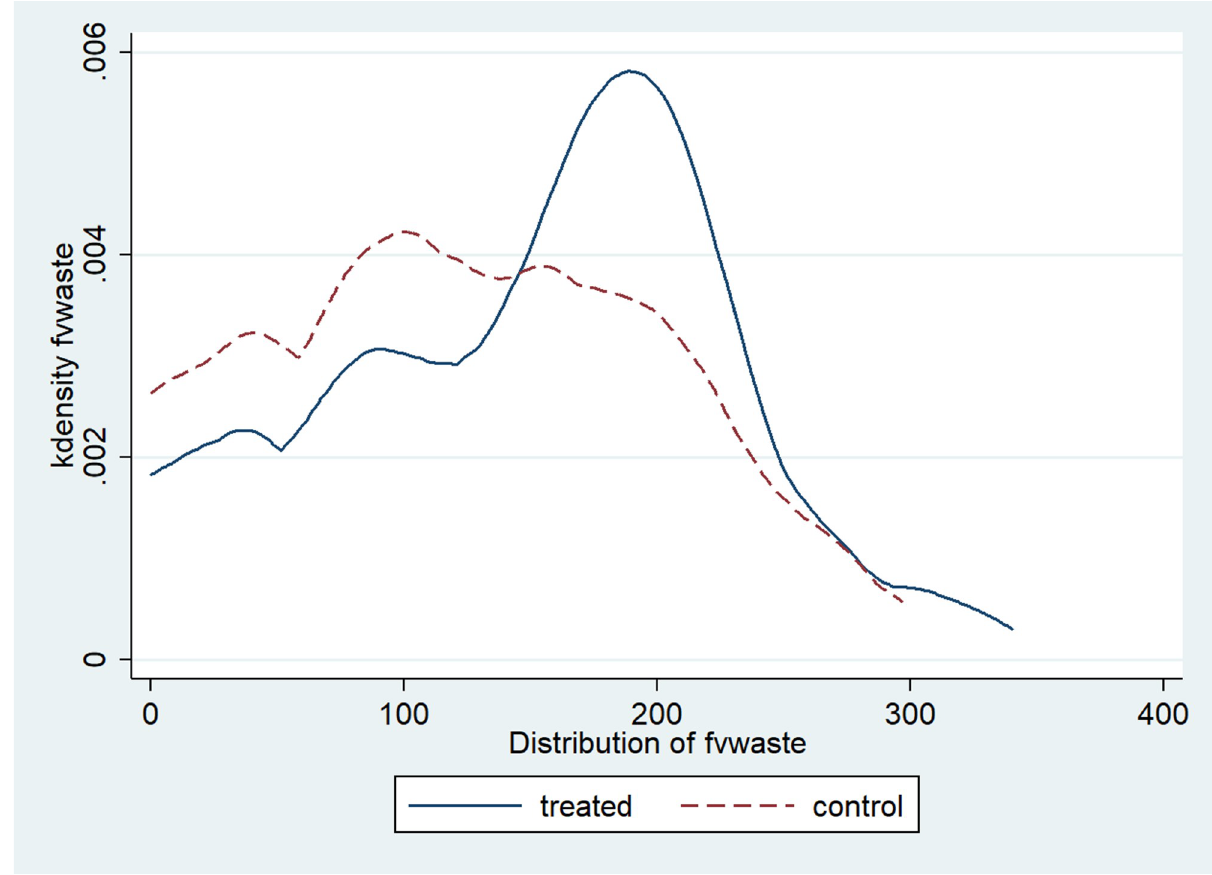
Fig 2. Distribution of fruits and vegetables